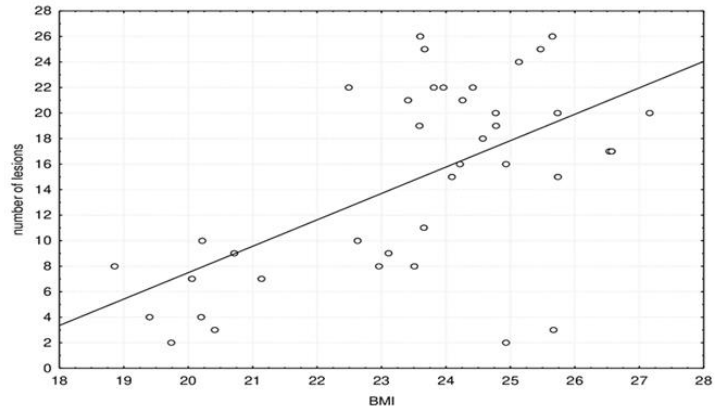
Figure 4. Scatter plot of the correlation between the number of brain lesions and BMI. The number of brain lesions significantly correlated with BMI: Spearman correlation coefficient rho = 0.469 ( p = 0.003). Figure 5 shows the correlation between the number of brain lesions with the platelet count. Figure 5. Scatter plot of the correlation between the number of brain lesions with platelet count. The number of brain lesions significantly correlated with the platelet count: Spear- man correlation coefficient rho = 0.599 ( p < 0.001). Figure 6 shows the correlation between the number of brain lesions with the degree of VAS.